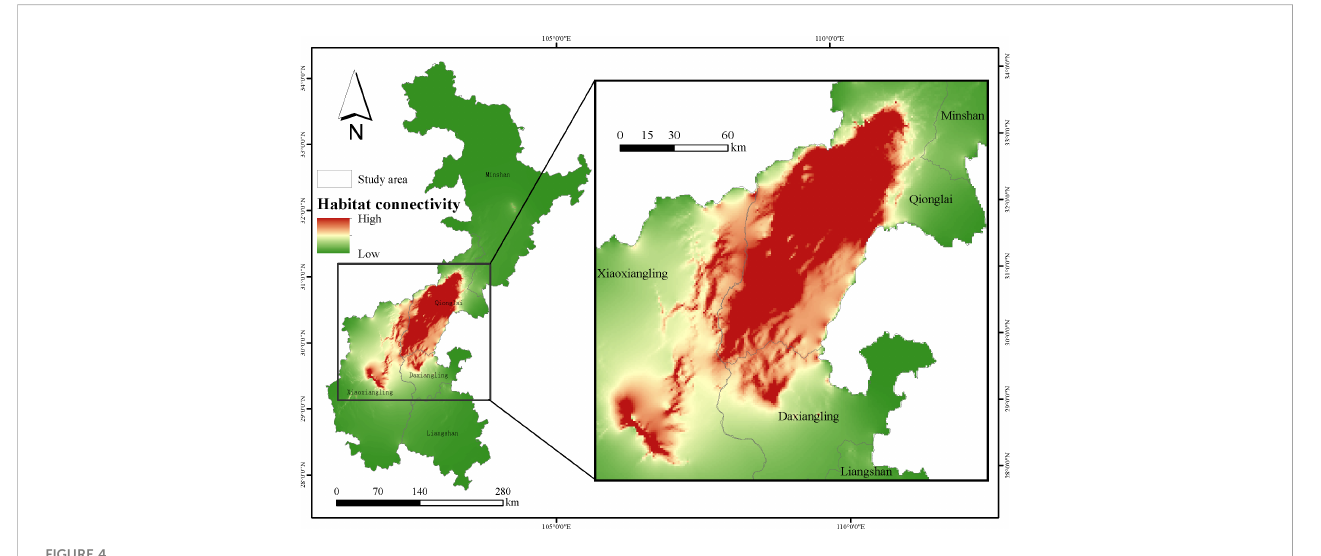
FIGURE 4 Habitat connectivity of